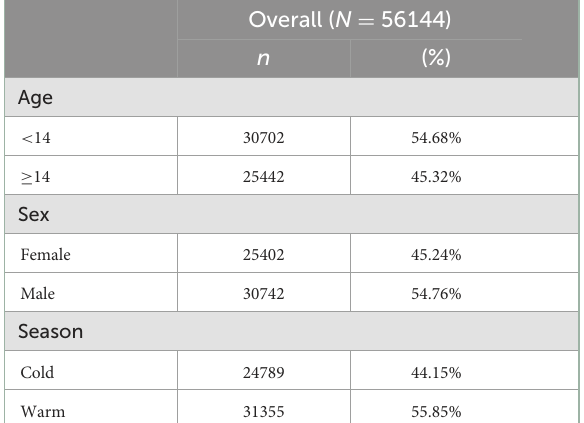
TABLE 1 Demographic characteristics of outpatients in fever clinics in Zhuhai,